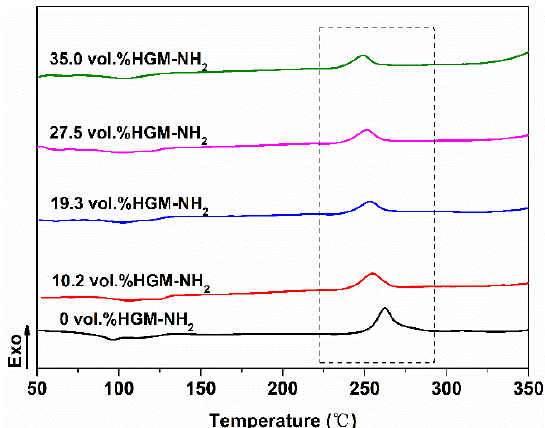
Figure 3. DSC curves of PBDP/HGM-NH 2 blends with different weight percentage of HGM-NH 2 (0~35.0 vol.%).